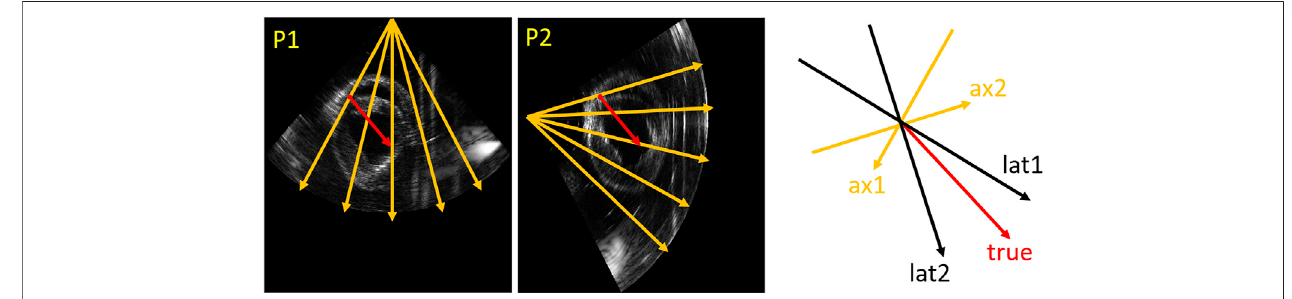
FIGURE 4 | Vector representation. An example (relative angle 75 ° ) in the tracking mesh is shown (red point), where orange (ax1, ax2), black (lat1 and lat2) and red (true) arrows represent axial, lateral and true directions, respectively.